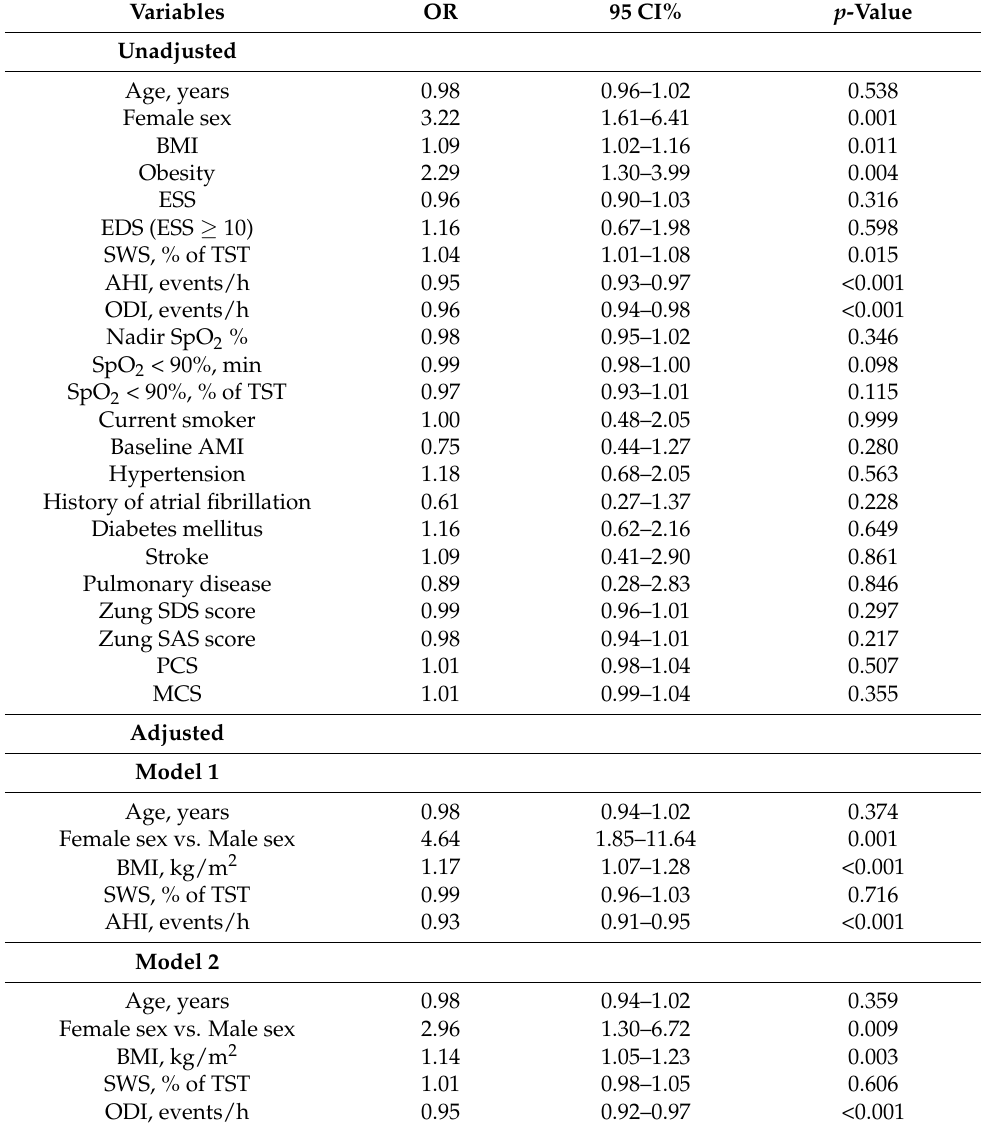
Table 4. Unadjusted and adjusted ORs (95% CIs) for variables associated with REM predominant